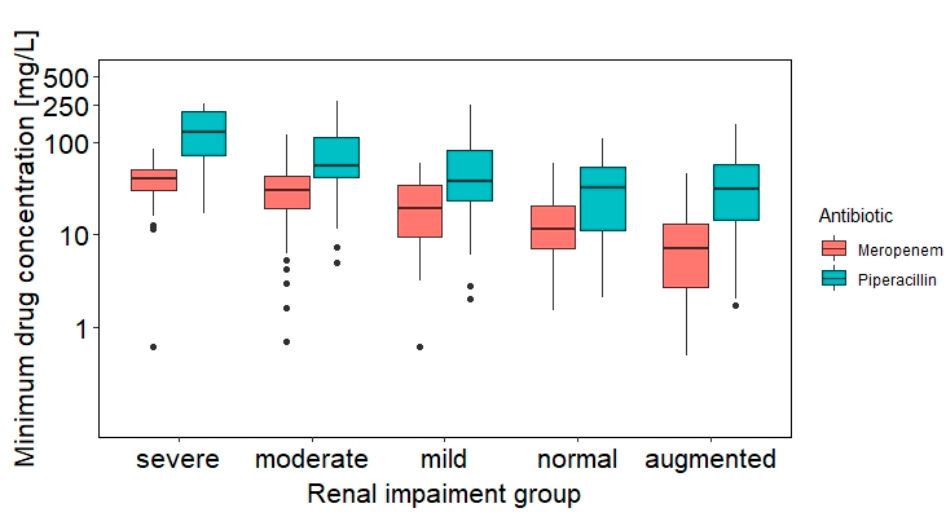
Figure A1. Minimum meropenem concentrations by renal function group. Boxes: interquartile range (IQR), horizontal line: median, whiskers: range below first or above third quartile to 1.5-fold the IQR, points: concentrations outside whiskers.